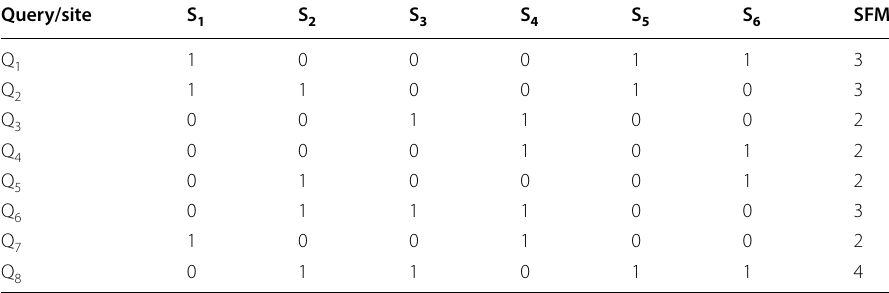
Table 4 Query Usage Matrix (QUM)